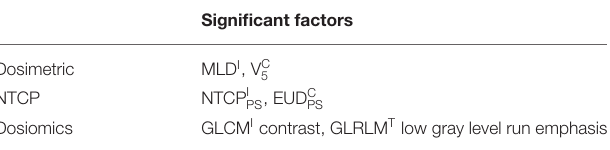
TABLE 2 | Multivariate LR prediction model * .